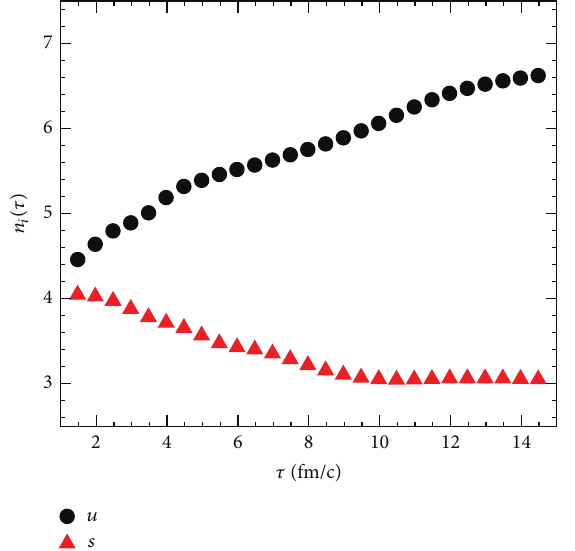
Figure 5: The time dependence of the rapidity densities of quark numbers, 𝑛 𝑖 (𝑡) , defined in (11) (color online).